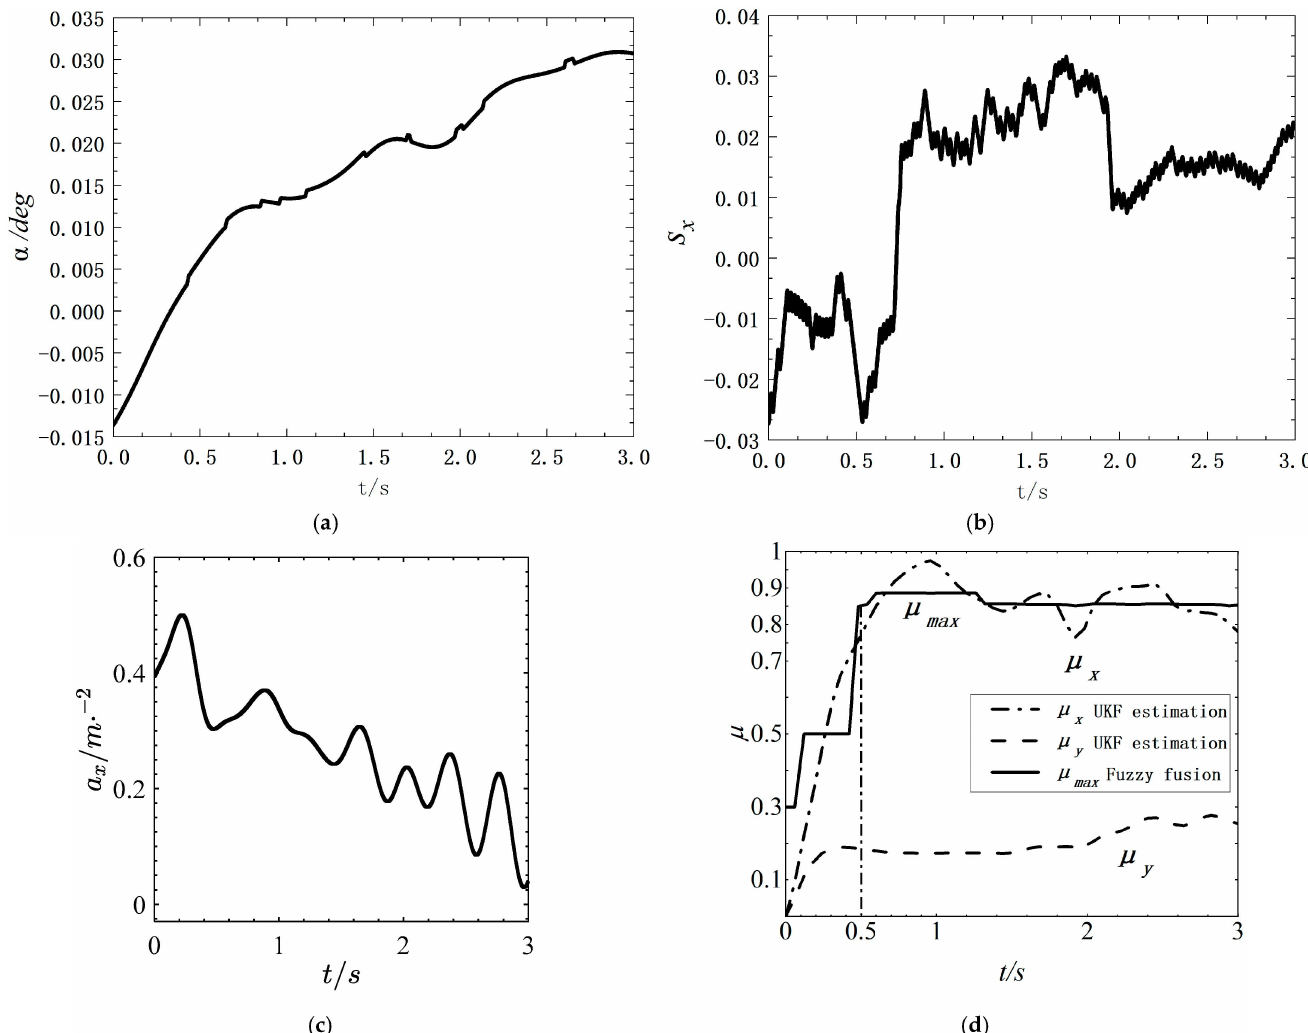
Figure 15. Simulation results under linear braking conditions. ( a ) Lateral deflection angle. ( b ) Longi- tudinal slip rate. ( c ) Longitudinal acceleration. ( d ) Estimated results of pavement adhesion